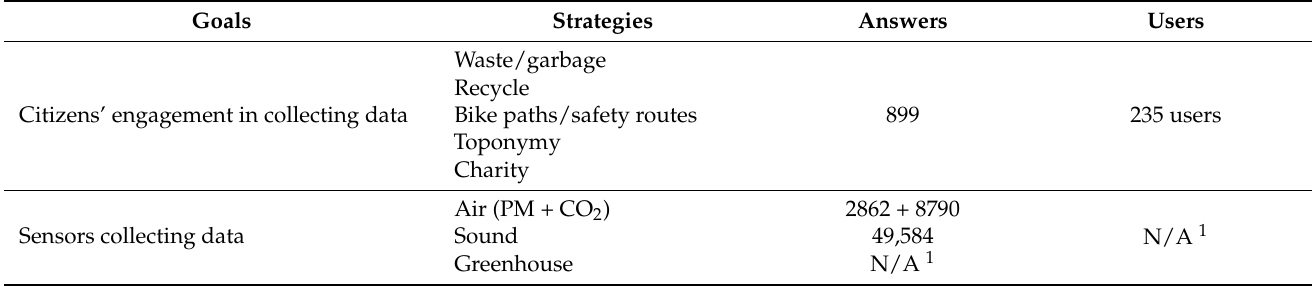
Table 7. Citizen sciences strategies.